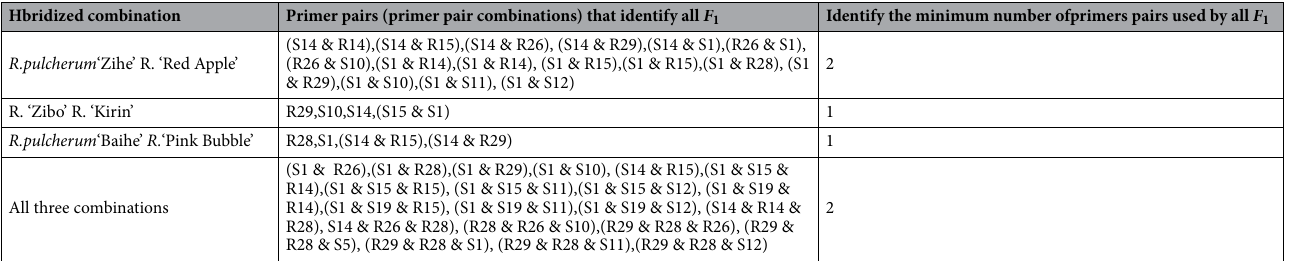
Table 6. Identification of Azalea subgeneration combined marker.